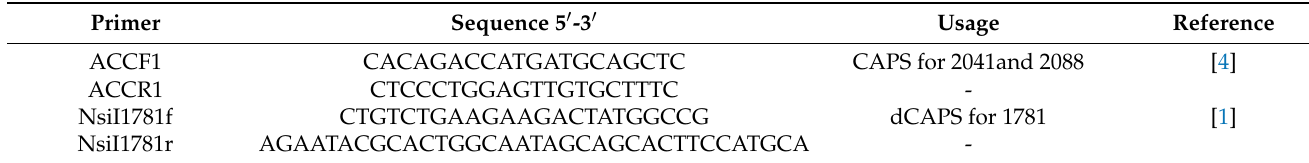
Table 2. Sequences of CAPS and D CAPS Primers.